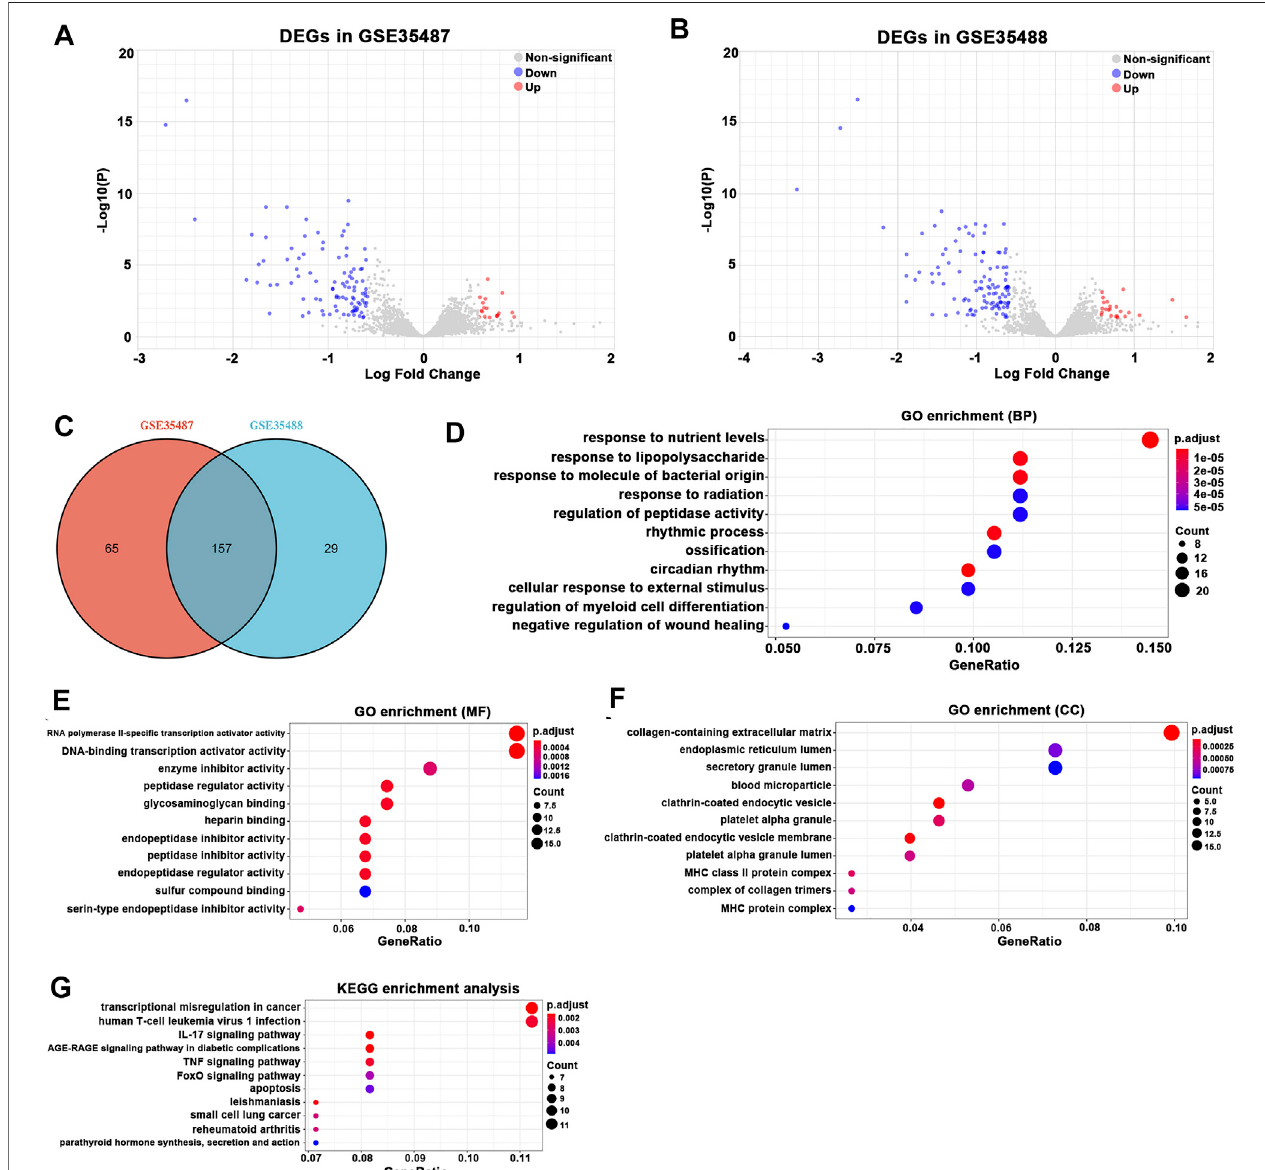
FIGURE3| Differentiallyexpressedgene(DEG)expressionbetweenhealthylivingdonorandIgAN. (A) Intotal,222DEGs(144upregulatedand78downregulated) inGSE35487wereselectedbyvolcanoplot fi ltering(adjustedp < 0.05and|log2(FC)| > 1). (B) Intotal,186(128upregulatedand58downregulated)DEGsinGSE35488 were selected by volcano plot fi ltering (adjusted p < 0.05 and |log2 (FC)| > 1). (C) In total, 157 overlapping DEGs (113 upregulated and 44 downregulated) between GSE35487 and GSE35488 as showed by the Venn plot. (D – F) GO analyses results of DEGs. (G) Pathway analyses results of